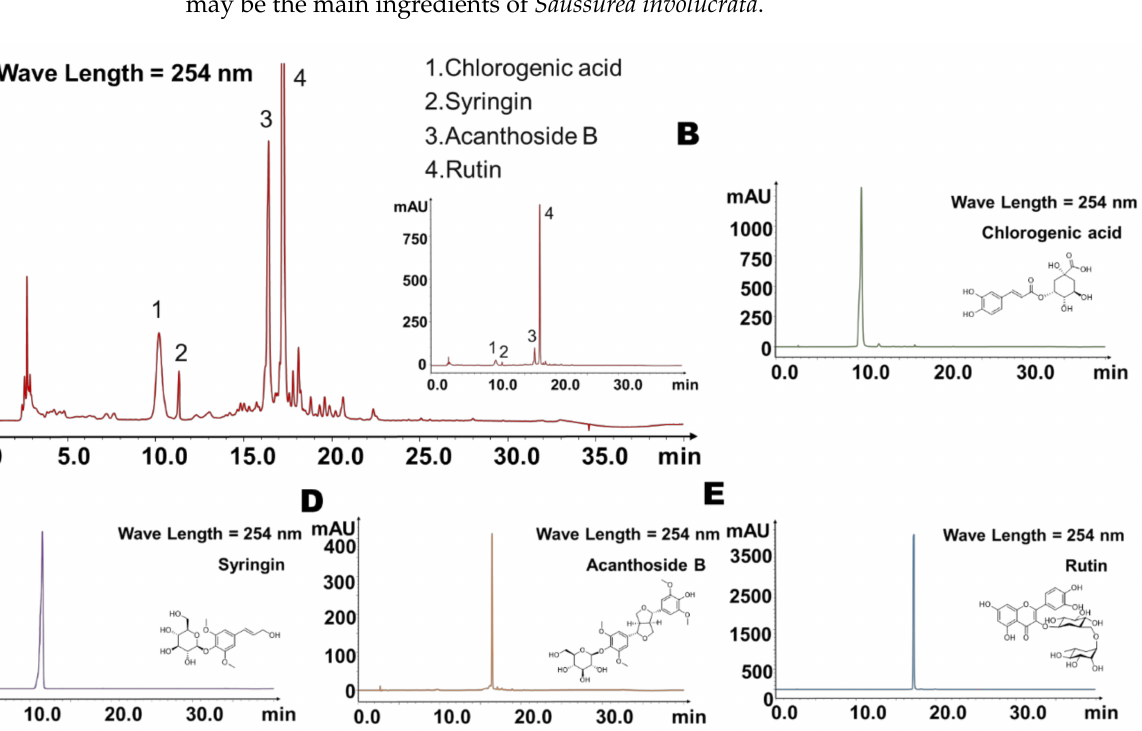
Figure 1. Fingerprint of Saussurea involucrata . ( A ) Fingerprint of Saussurea involucrata , with the four main components marked in the chromatogram. ( B ) Chromatogram of chlorogenic acid stan- dard. ( C ) Chromatogram of syringin standard. ( D ) Chromatogram of acanthoside B standard. ( E ) Chromatogram of rutin